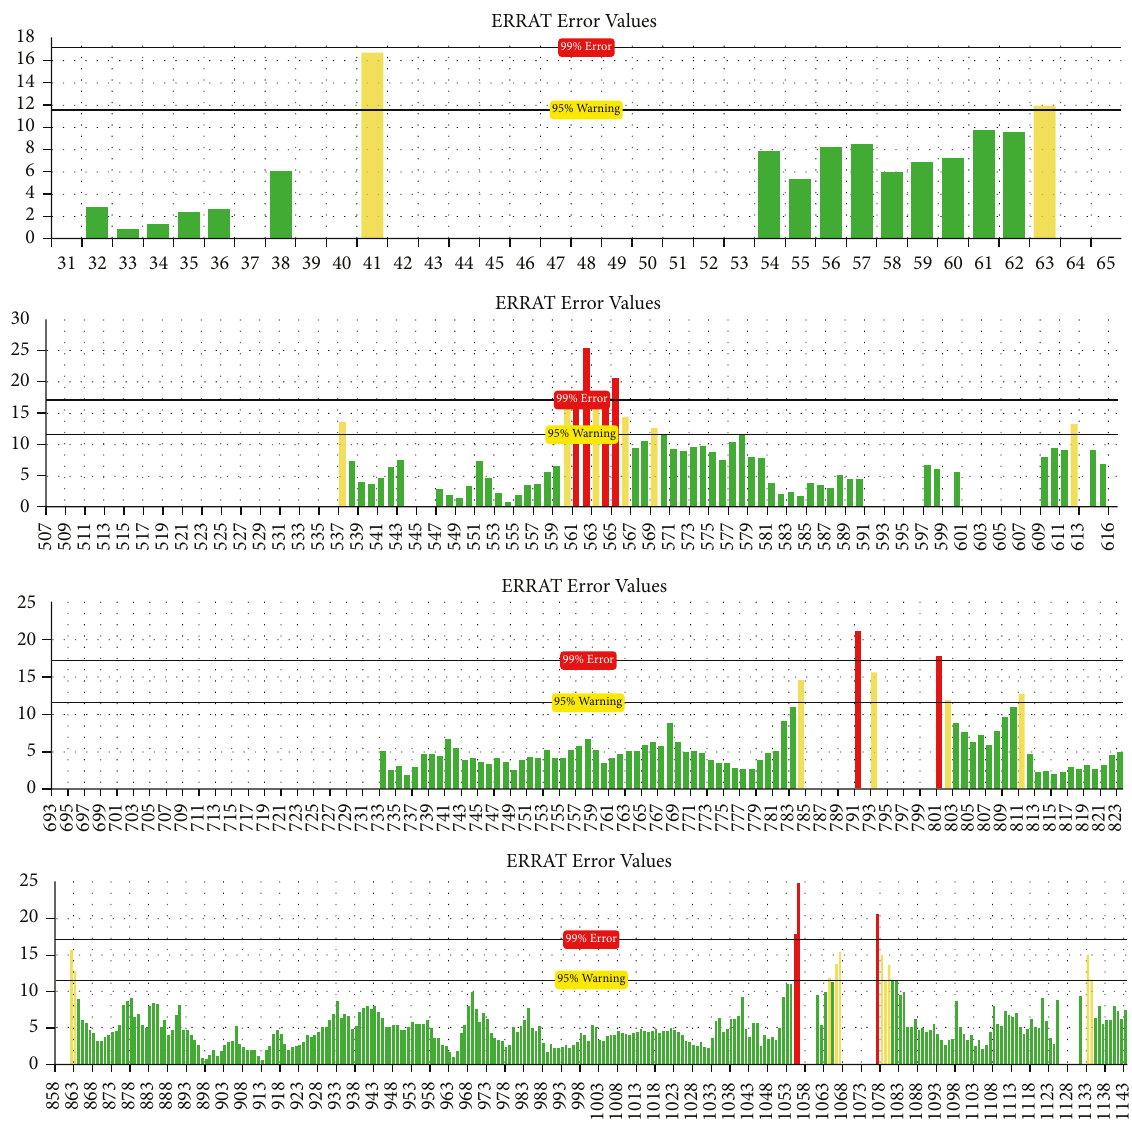
Figure 4: Evaluation of protein model of SARS-CoV-2-SG by